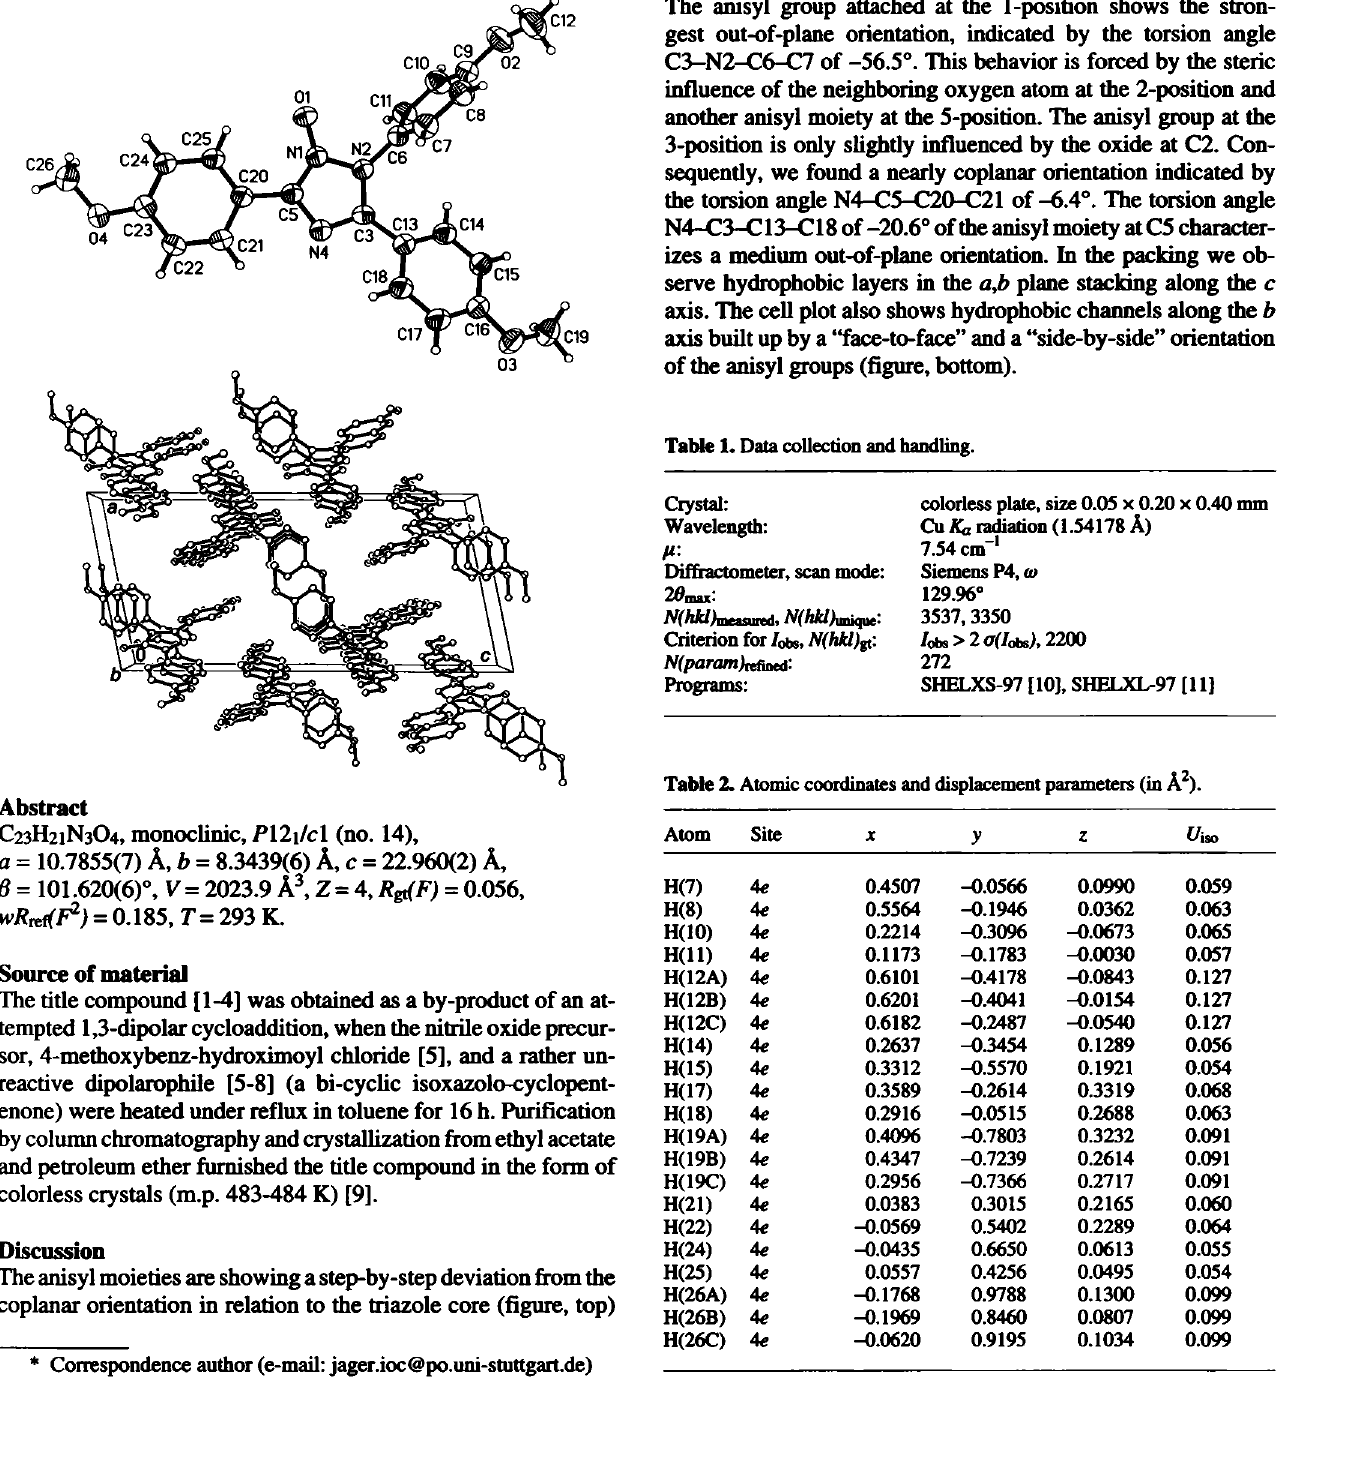
Table 2. Atomic coordinates and displacement parameters (in Ä 2